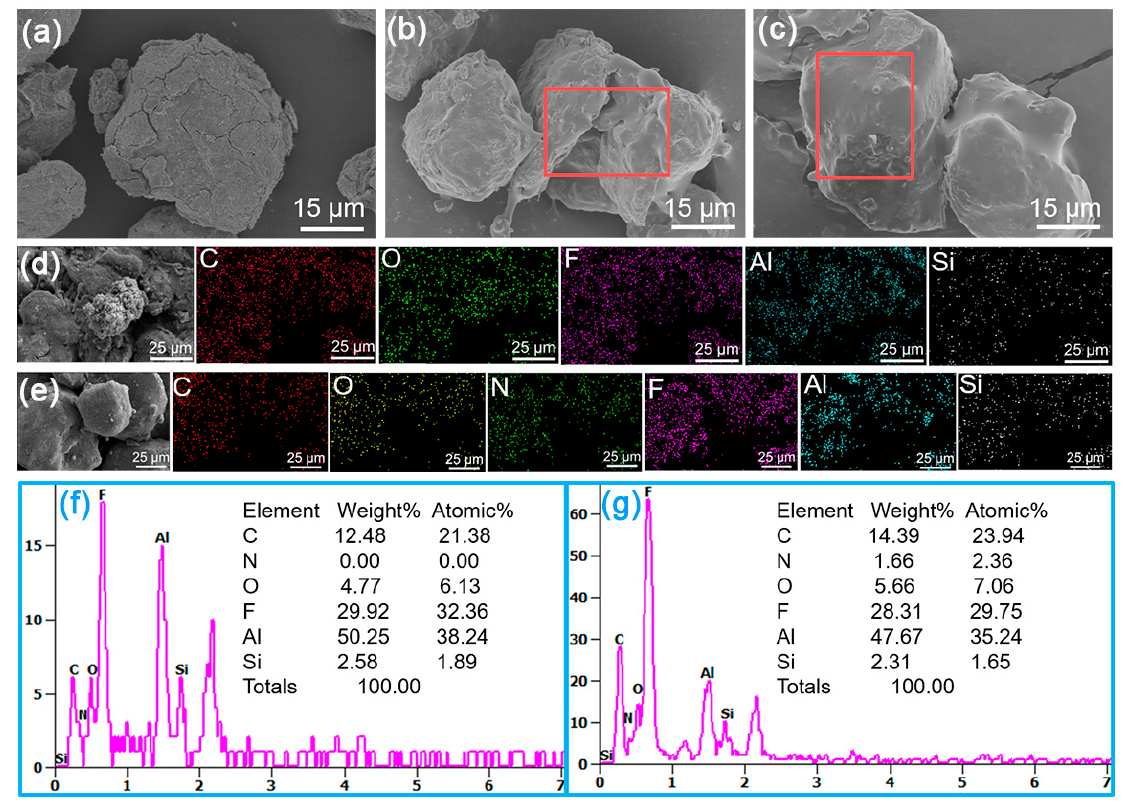
Figure 2. The SEM images of w-Al ( a ), w-Al@FAS-17 ( b ) and w-Al@FAS-17@GAP ( c ); EDS mapping images of w-Al@FAS-17 ( d ) and w-Al@FAS-17@GAP ( e ); EDS point scanning images of w-Al@FAS-17 ( f ) and w-Al@FAS-17@GAP ( g ).